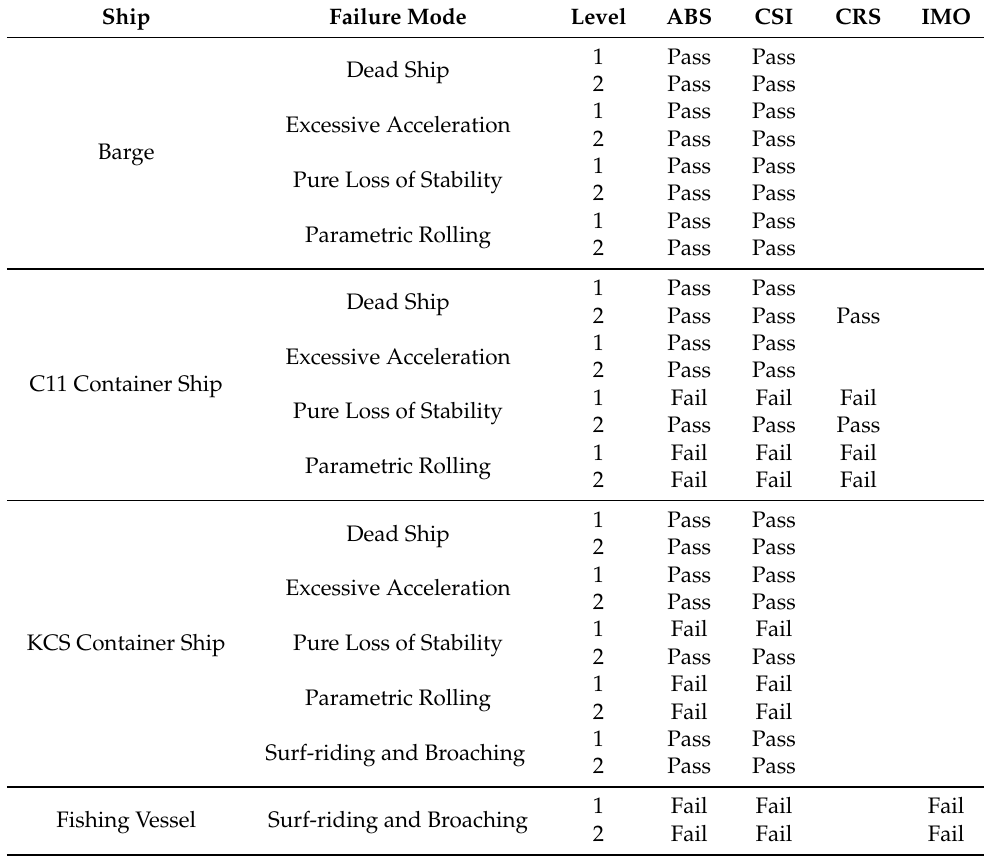
Table 41. Level 1 and level 2 assessment of five failure modes for four